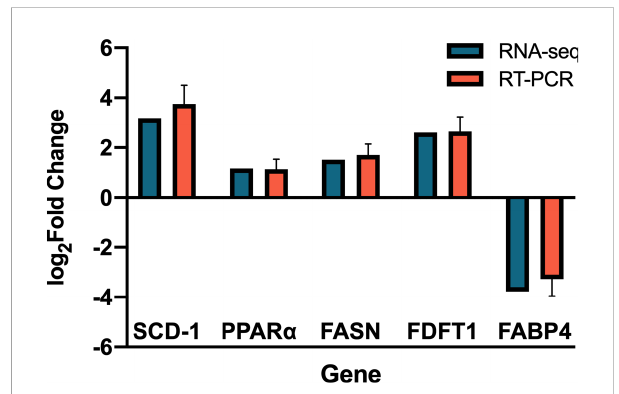
FIGURE 7 Comparison of gene expression data between RNA-seq and quantitative real-time PCR (RT-PCR).